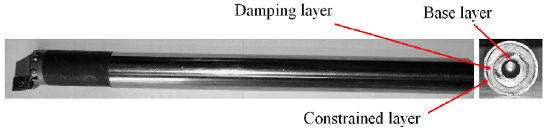
Figure 5. Boring bar with passive CLD